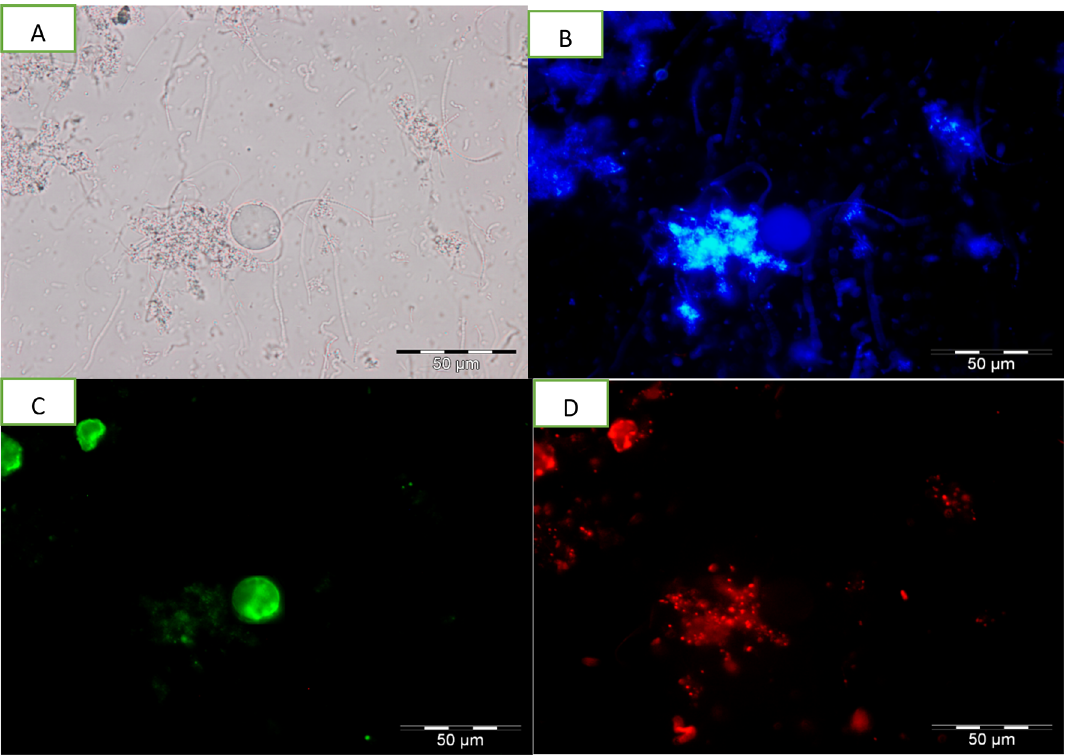
Figure 8. Images of EU treated (0.01 mg/ml) Blastocystis sp. undergoing apoptosis viewed under epifluorescent microscope; ( A ) Bright field; ( B ) stained using Hoechst stain; ( C ) stained using FITC Annexin (V); ( D ) stained using Propidium